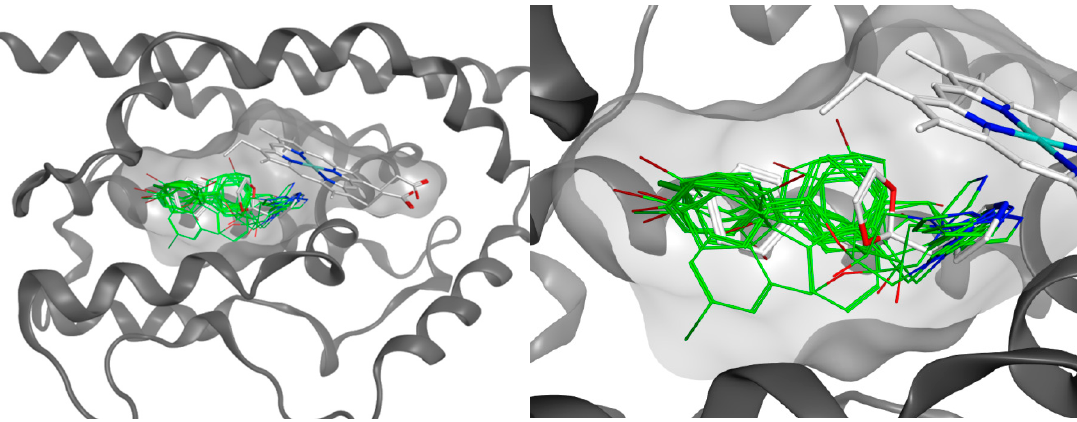
Figure 3. Binding poses of 2a – c , 5a – f, and 6a , b (green) compared to the crystallized pose of QC-15 (white).